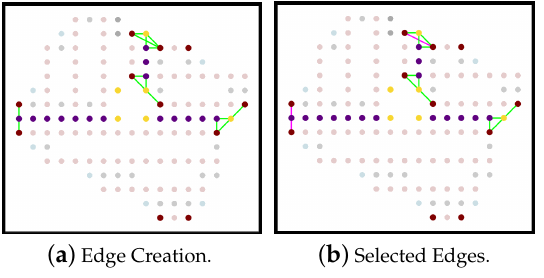
Figure 18. A sample of joining three partitioned areas.